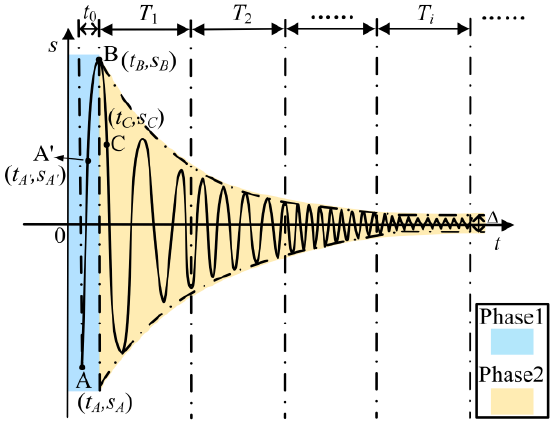
Figure 3. Adaptive mechanism of the online zero-crossing